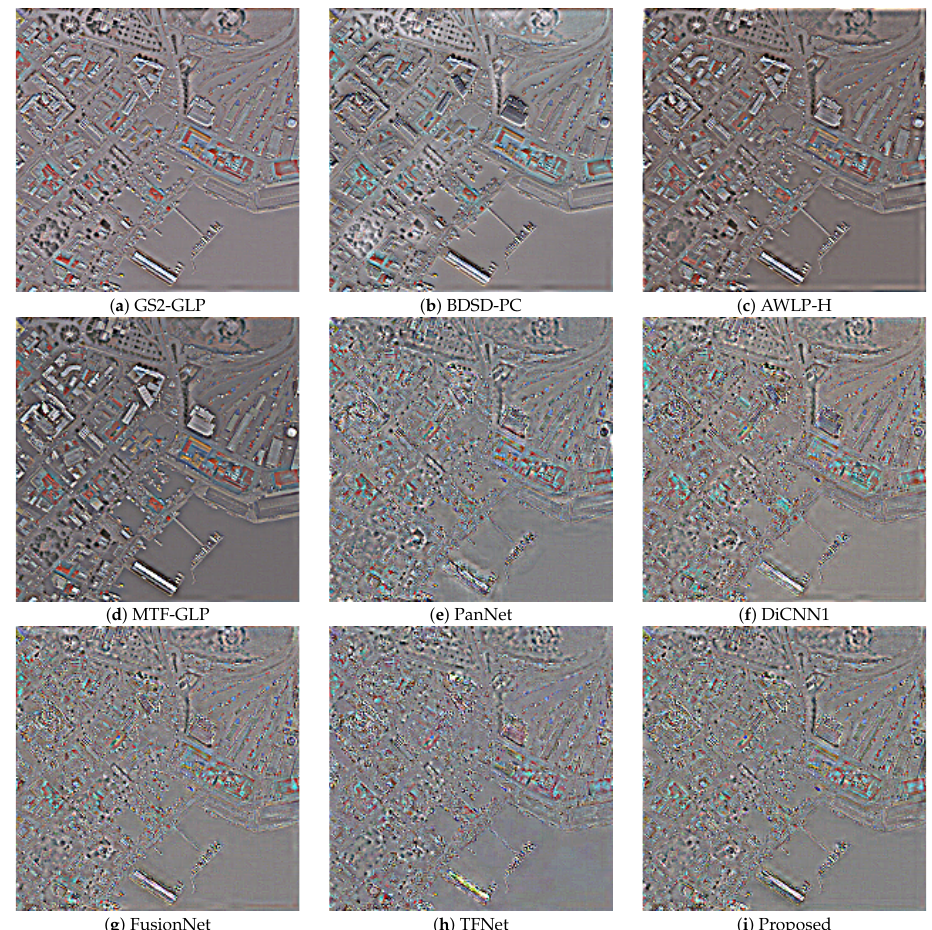
Figure 3. Residual images of the fusion results shown in Figure